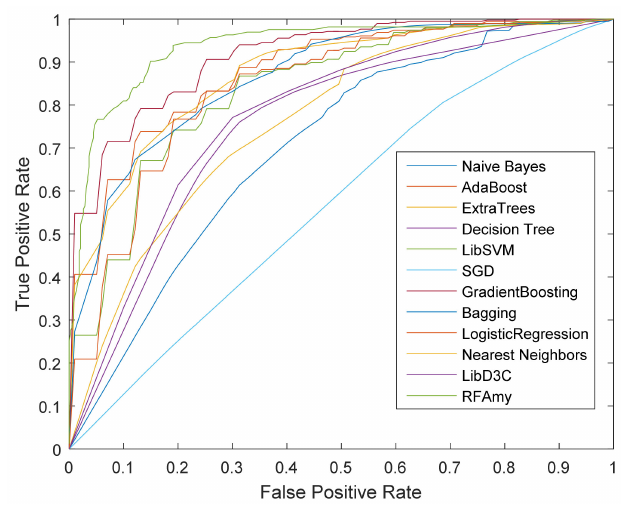
Figure 1. Receiver Operating Characteristic (ROC) curve for RFAmy and other methods.